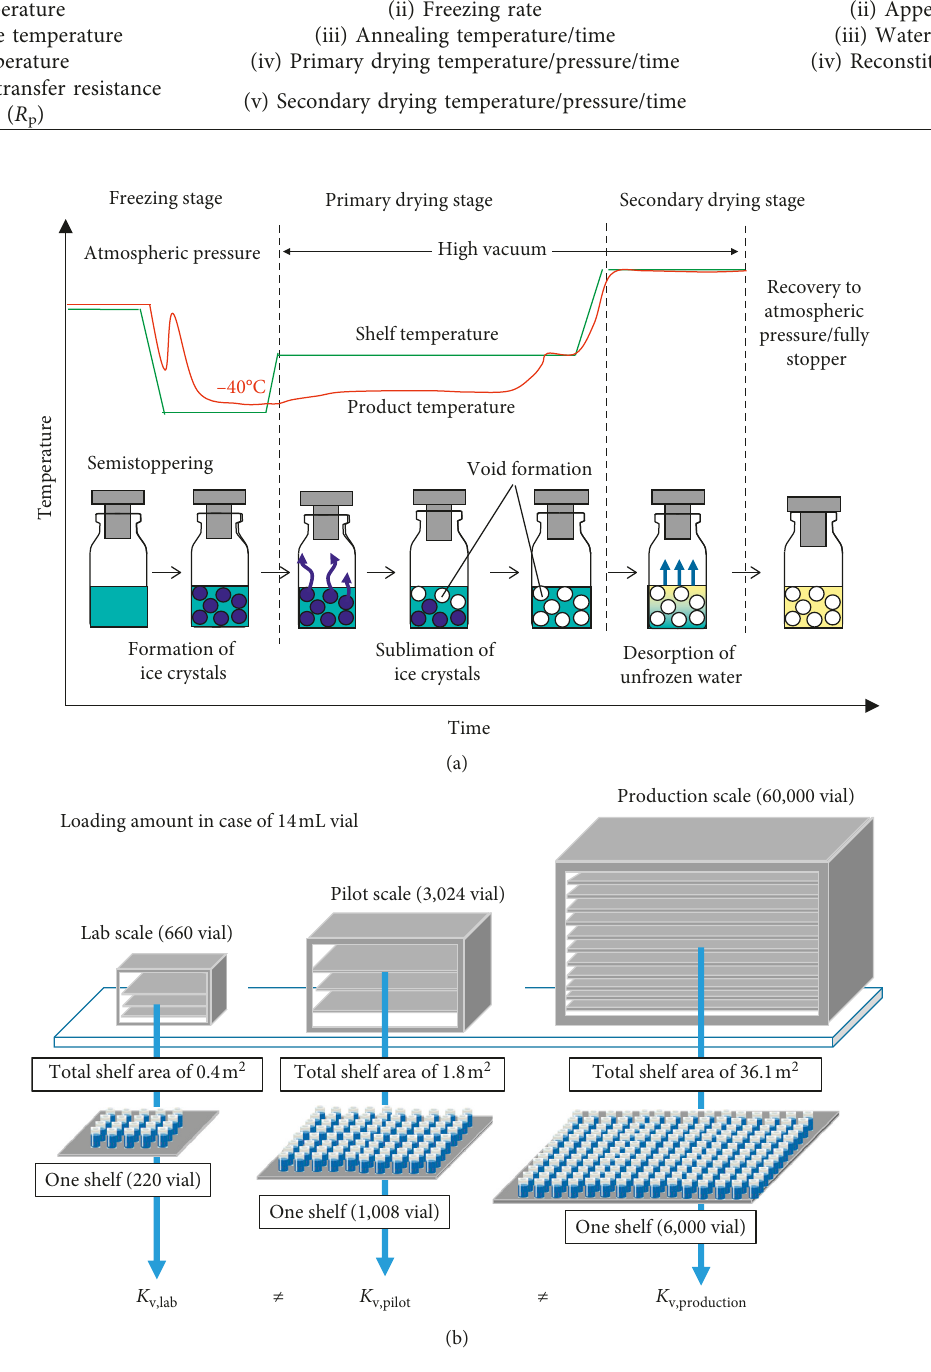
Figure 1: (a) Schematic illustration of lyophilization process. Green and red curves represent the shelf temperature and product tem- perature, respectively. (b) Comparison of lab, pilot, and production lyophilizers.